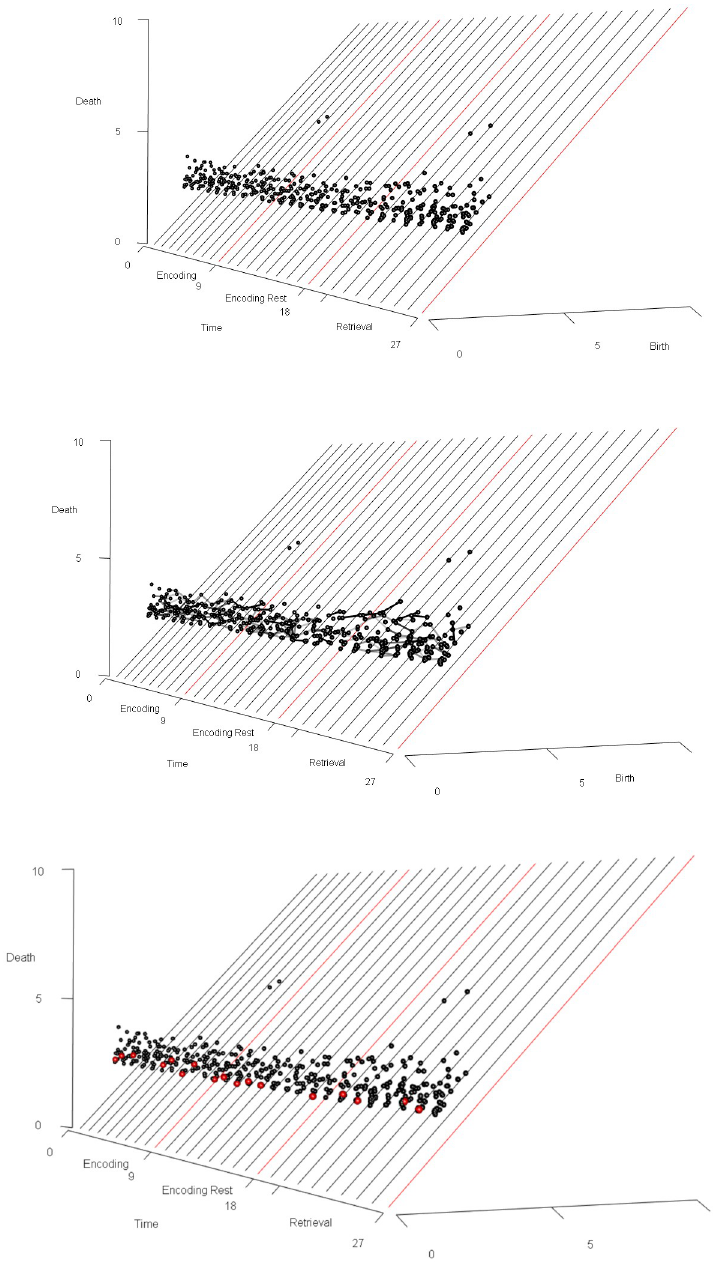
Fig 9. Building from a single time index (in Fig 8), we present persistence diagrams at each of the first 27 time indices in the analyzed fMRI data. The results are stacked to form a three-dimensional image, with time as the third axis (and with birth radius and death radius as the other two axes, consistent with Fig 8). For the sake of visual clarity, we omit features of relatively low persistence from this image. The result is depicted in three complementary views. In the top subfigure, we simply show the stacked persistence diagrams. In the middle subfigure, we present the persistence vineyard, in which the top subfigure is supplemented with line segments indicating the anatomical proximity (i.e., the Hausdorff distance in real stereotactic space) between the representative loops in each homology class. Darker line segments indicate anatomically more proximate loops, while lighter line segments indicate loops which are more anatomically distant from one another. A dark, distinct “vine” represents a loop-shaped topological structure in the fMRI data which is stable over time. The bottom subfigure has red dots indicating a particular vine which our statistical test has identified as being task-correlated, that is, a persistent homology class is present in the vine’s region of stereotactic space at some time indices and not at others, and over the full run of 288 time indices, the presence of the vine at a time index was positively correlated (p < 0.01) with that time index being within the memory encoding epoch of the